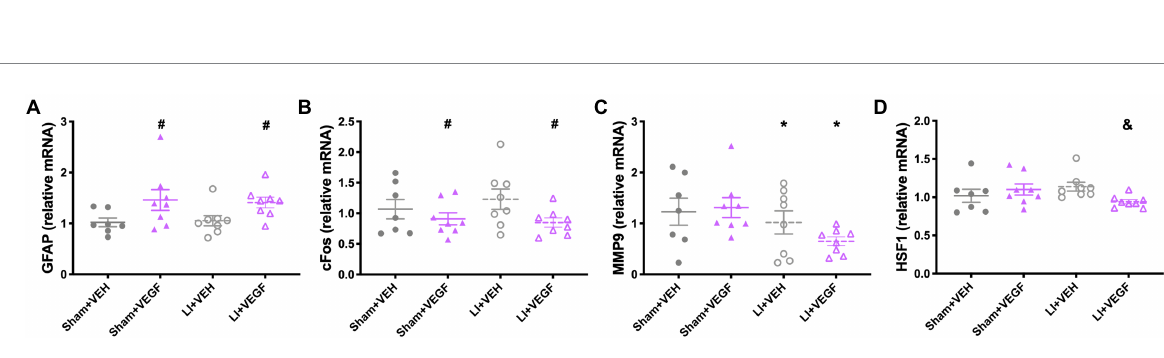
FIGURE 5 Gene expression in the hippocampus of female rats. VEGF rats had increased GFAP expression (A) and decreased cFOS expression (B) than VEH rats. (C) LI rats had less MMP9 expression than sham rats. (D) LI + VEGF rats had decreased HSF1 expression than the LI + VEH rats. *, LI rats significantly different than sham rats; #, VEGF treated rats significantly different than VEH treated rats; &, LI + VEGF significantly different than LI + VEH; p < 0.05. n = 7–8 per group, except for EPO , n = 4–6 per group due to undetectable levels in some samples. Error bar =